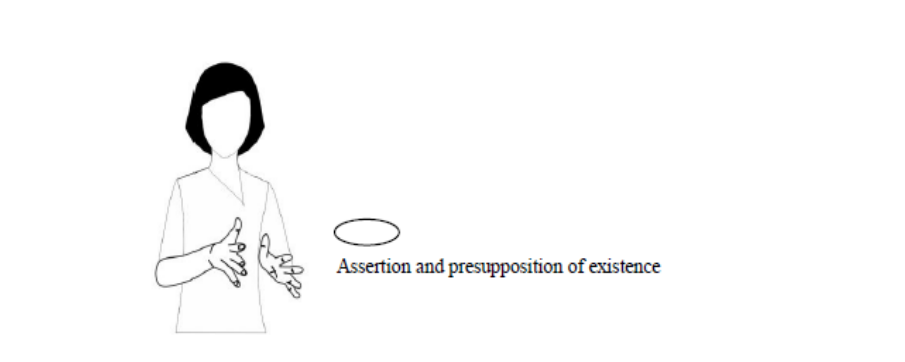
Figure 1. Definiteness marking in LSC signing space